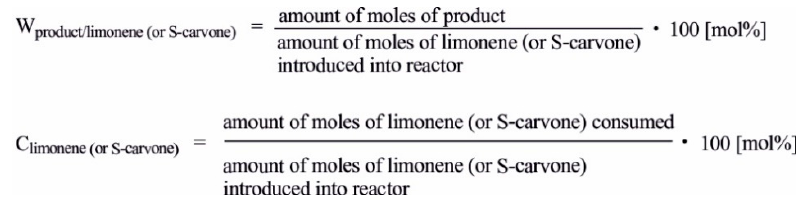
Figure 16. Method of calculating the yields of products and the conversions of raw materials.